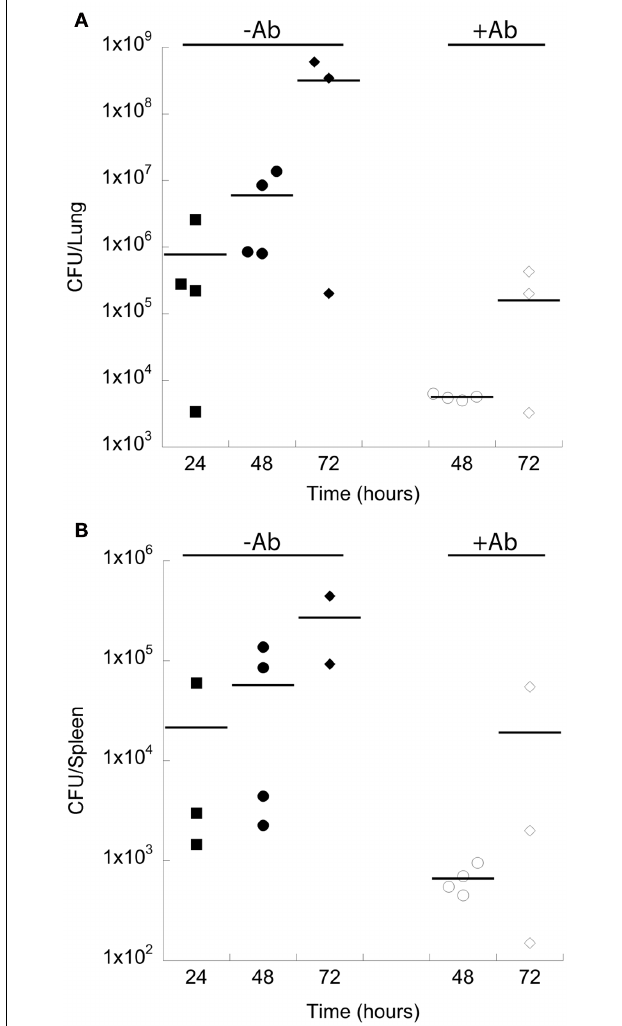
FIGURE 6 | B. mallei bacterial burden in treated and untreated BABLB/c mice. CSM001 was i.n. inoculated into BALB/c mice as indicated previously for the bioluminescent imaging. At each time point, untreated (closed symbols) or treated (open symbols) animals with 20mg/kg/day of levofloxacin were sacrificed and the lungs (A) and spleen (B) were harvested at 24h (squares), 48h (circles), 72h (diamonds) and plated for CFU determination.